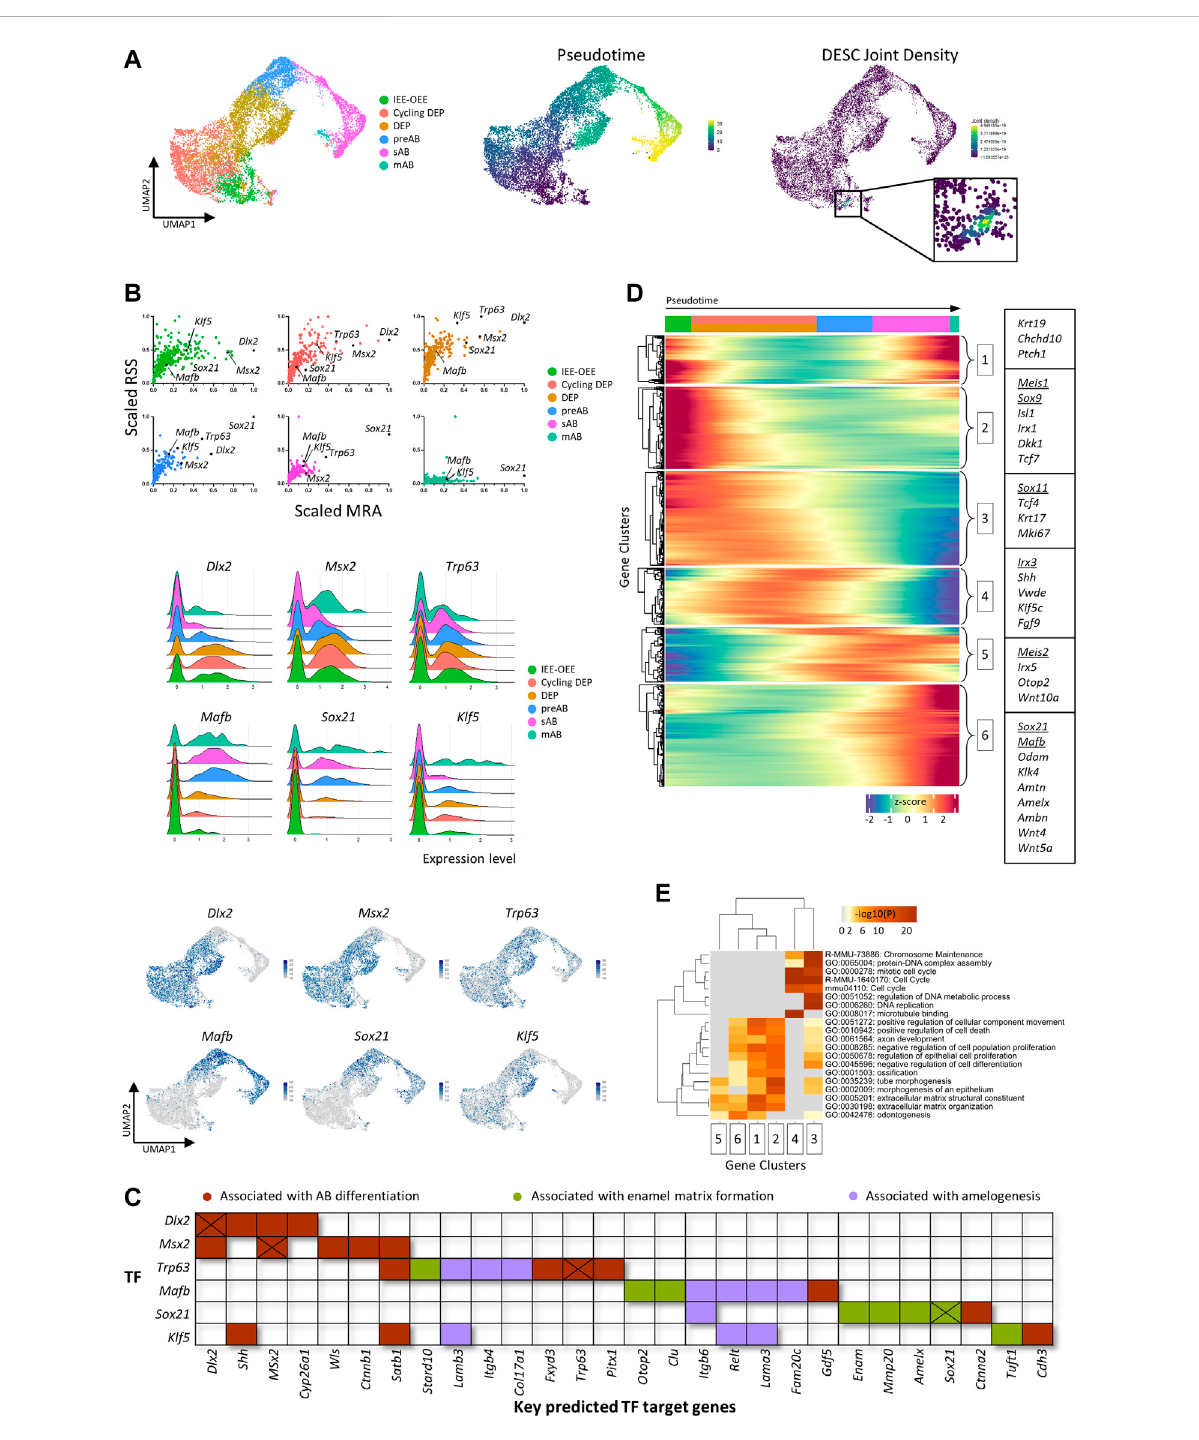
FIGURE 2 Subclustering of the mouse ameloblast lineage. (A) UMAP plots of subclustered ameloblast lineage (left), pseudotime trajectory (starting from the IEE-OEE cluster; middle) and joint Nebulosa expression density for the DESC marker panel (right). (B) Scatter plots (per annotated epithelial cell cluster, color-coded) of scaled RSS and MRA with each dot corresponding to an individual regulon and black dots indicating the marked regulons (top), and ridge (middle) and feature (bottom) plots indicating gene expression of selected TF/regulons. (C) Map indicating key predicted target genes of identi fi ed TF. Genes are color-coded based on association with AB differentiation (brown), enamel matrix formation (green) or amelogenesis (purple). Cross marks indicate potential self-Induction/upregulation. (D) Pseudotime-ordered (from left to right) gene expression heatmap of the ameloblast trajectory in panel (A) . Color intensity indicates z-score normalized gene expression (legend at bottom). Genes were clustered into six groups using k-means clustering. Boxes indicate examples of genes for each cluster (in-text mentioned genes are underlined). (E) Heatmap of GO analysis on clustered genes from panel (D) . Color intensity indicates the p values of displayed GO terms (legend on